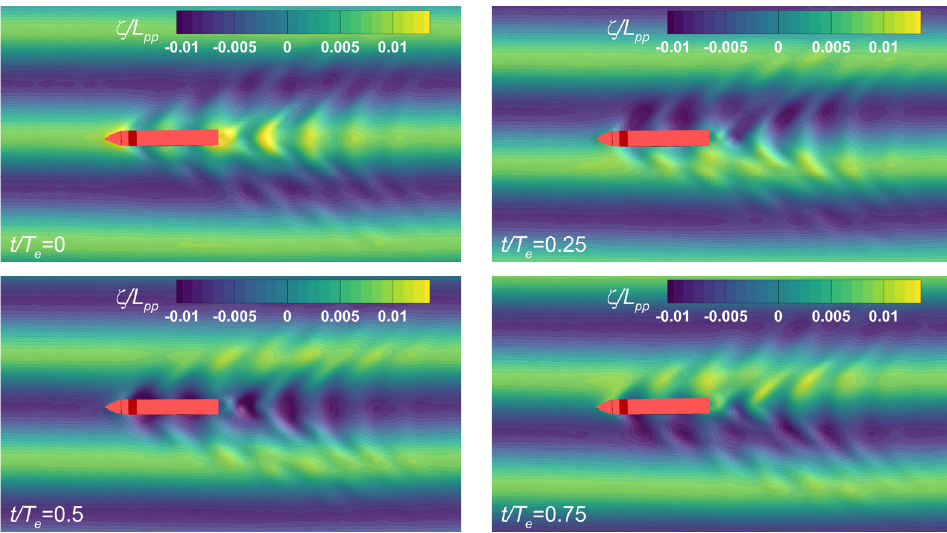
Figure 19. Free-surface elevations over a period of the beam wave encounter. The harmonic amplitudes and phases reconstructed from the Fourier series of the solution computed in the beam sea case are depicted in Figures 20 and 21, respectively.